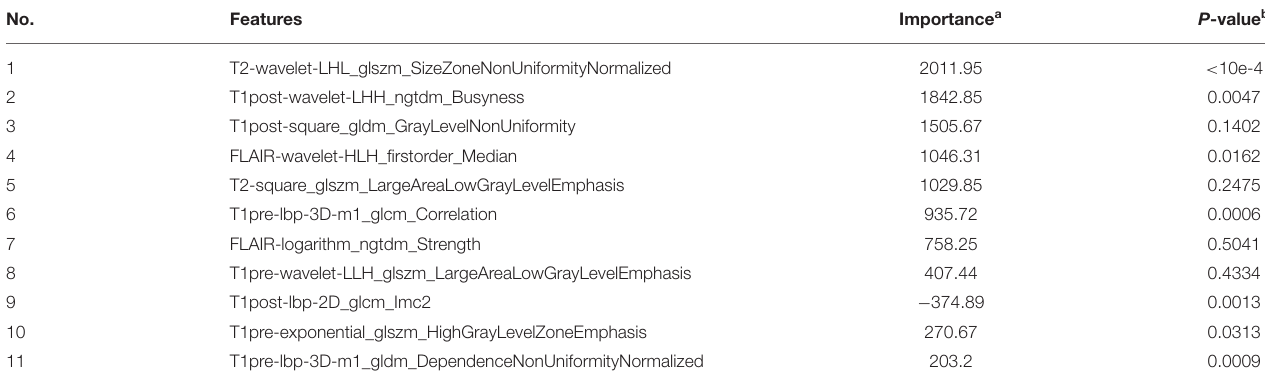
TABLE 4 | Eleven features used to predict CIC mutation in